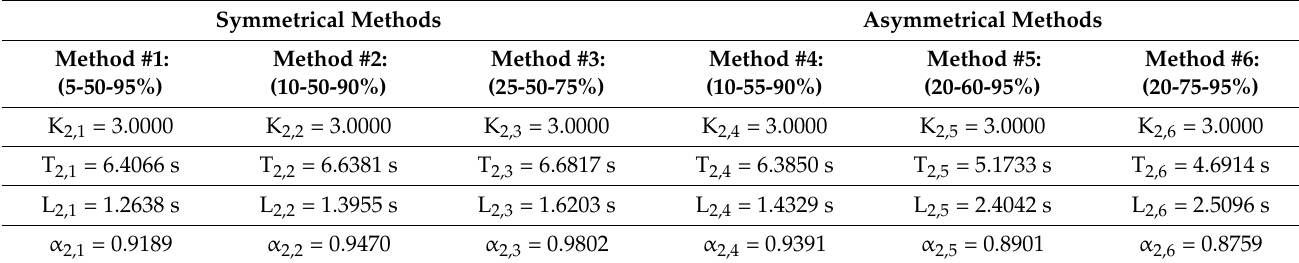
Table 17. Fractional-order model settings for the symmetrical and asymmetrical sets of points (5-50-